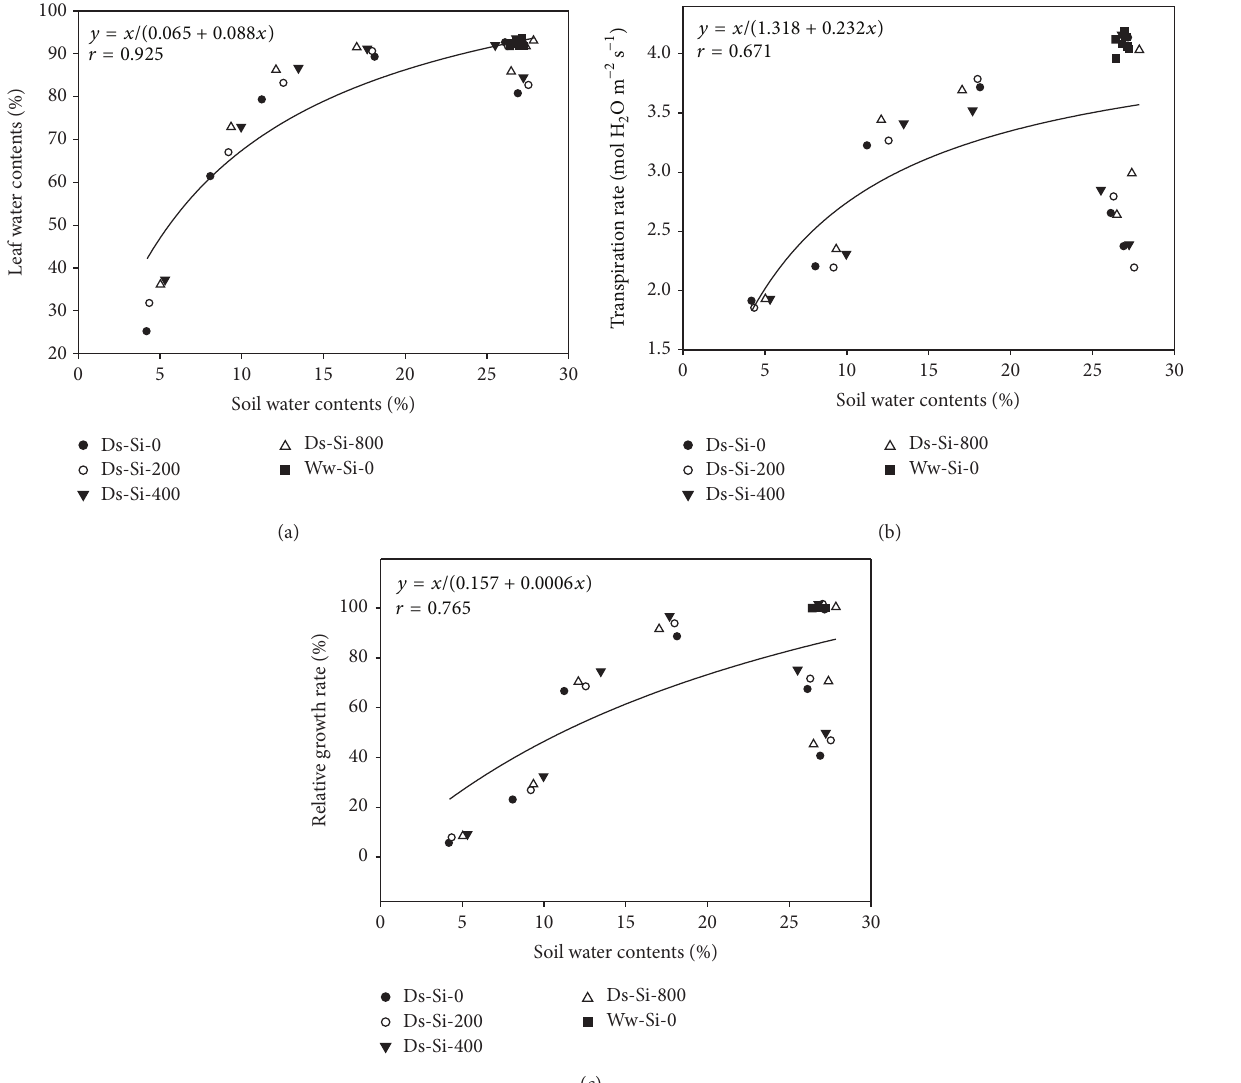
Figure 4: Relationship of soil water content with (a) leaf water content, (b) relative growth rate, and (c) transpiration rate using hyperbola regression